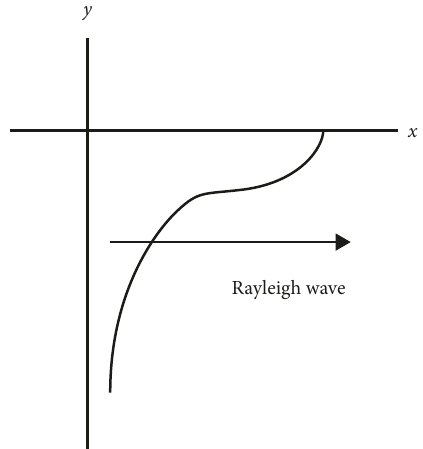
Figure 2: Rayleigh wave propagating on a surface